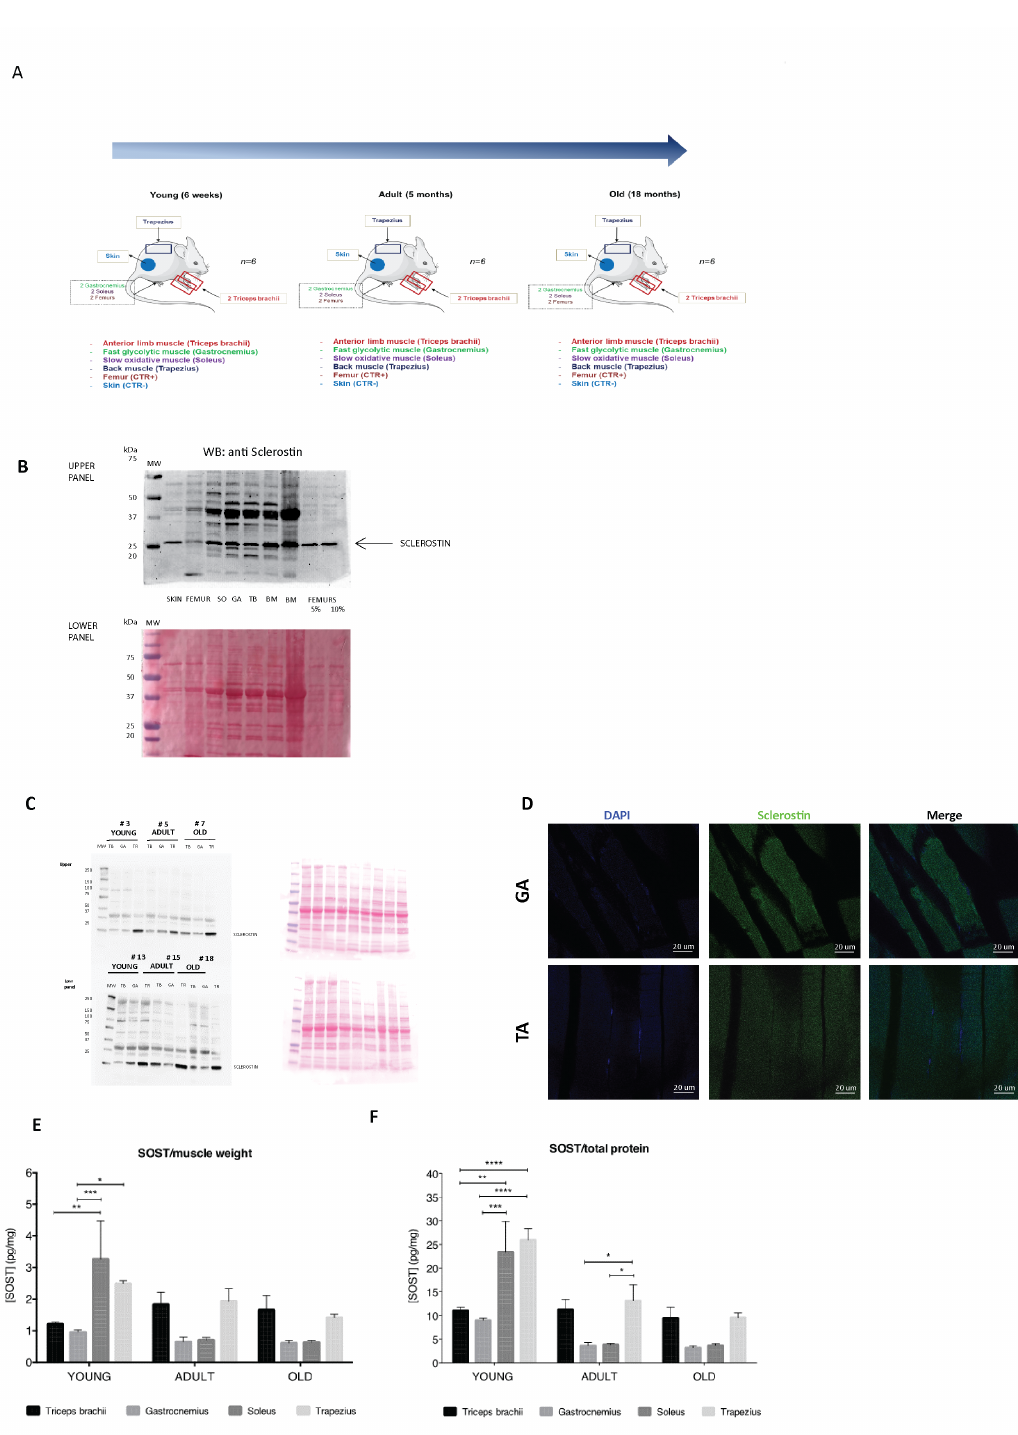
Figure 4. ( A ) Graphical scheme of the muscles obtained in mice of different ages. ( B ) Twenty ug of protein extracts obtained in different tissues were analyzed for the expression of sclerostin under normal and higher (5–10% β -mercapthoetanol) reducing conditions (upper panel). Ponceau staining for visualization of the equal number of loaded samples is in the lower panel. ( C ) Sclerostin expression in protein extracts obtained in different muscles. For each group of muscles, the sclerostin expression analysis was repeated for 2 animals (upper panel). Ponceau staining for visualization of the equal amount of loaded samples is represented in the lower panel. ( D ) Frozen sections of the gastrocnemius muscle were subjected to immunofluorescence staining of sclerostin. The cell nuclei were stained with DAPI. Scale: 20 µ m. ( E , F ) ELISA assay measuring the sclerostin amount in protein extracts from distinct muscle groups collected in mice of different ages: young (6 weeks), adult (5 months), old (18 months). The data are represented as the sclerostin amount related to muscle weight ( E ) and to the total extracted protein ( F ). * p < 0.05, ** p < 0.005, *** p < 0.0005, **** p <